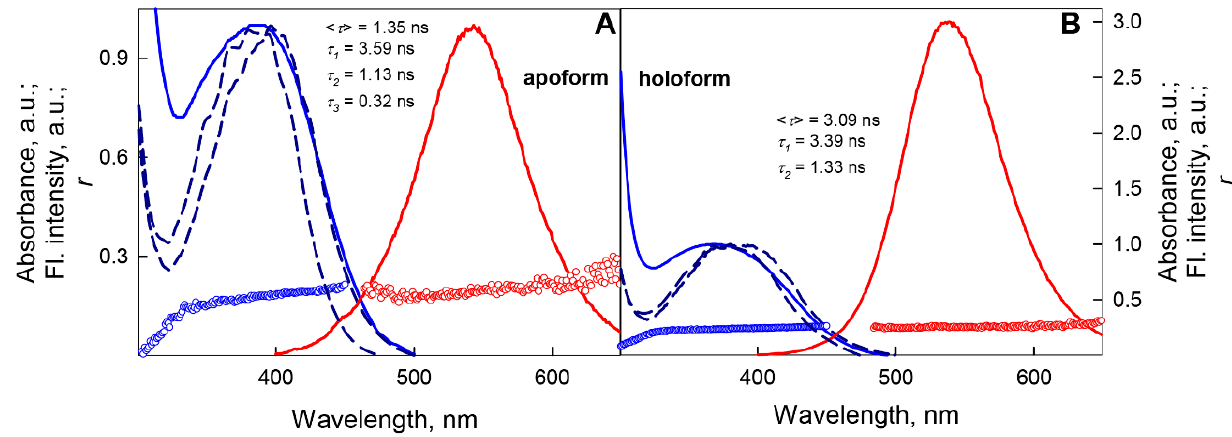
Figure 2. Spectral characteristics of BADAN bound to GGBP/H152C in apo panel ( A ) and holoform panel ( B ). The absorption and fluorescence spectra of BADAN are shown by solid blue and red curves, respectively. The absorption spectra are normalized to the signal intensity at the maximum of the long-wavelength band. The dye fluorescence spectra were measured at an excitation wavelength of 387 nm and normalized to the fluorescence intensity of BADAN attached to the GGBP/H152C apoform. The BADAN excitation spectra measured at fluorescence recording wavelengths of 475 and 530 nm and normalized to the intensity at the maximum of the spectrum are shown by blue dashed curves. The anisotropy spectra of BADAN fluorescence were measured at an excitation wavelength of 387 nm and are represented by red symbols. The excitation anisotropy spectra of BADAN were measured at a fluorescence recording wavelength of 530 nm and are represented by blue